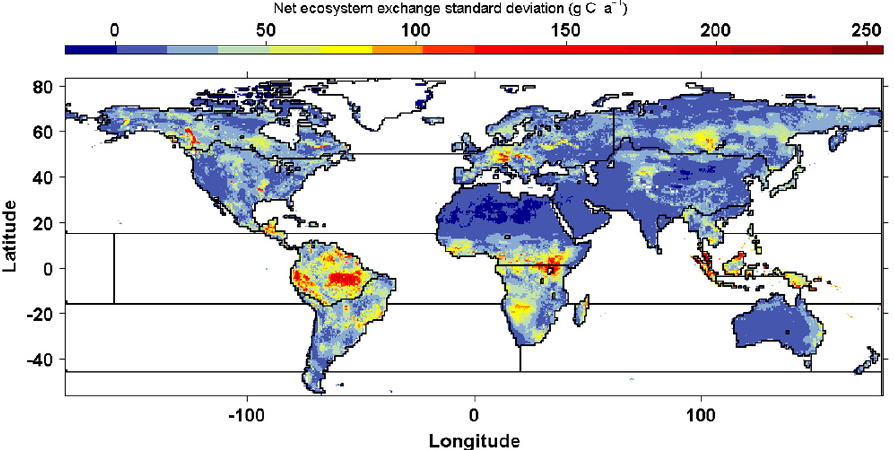
Fig. 2. Standard deviation of annual net ecosystem exchange (g C m − 2 a − 1 ) calculated from the 3 climate × 5 land cover forcing simulations. Borders represent TransCom 3 regions (Gurney et al., 2002) that correspond to biogeographic zones used in the analysis for Table 5.